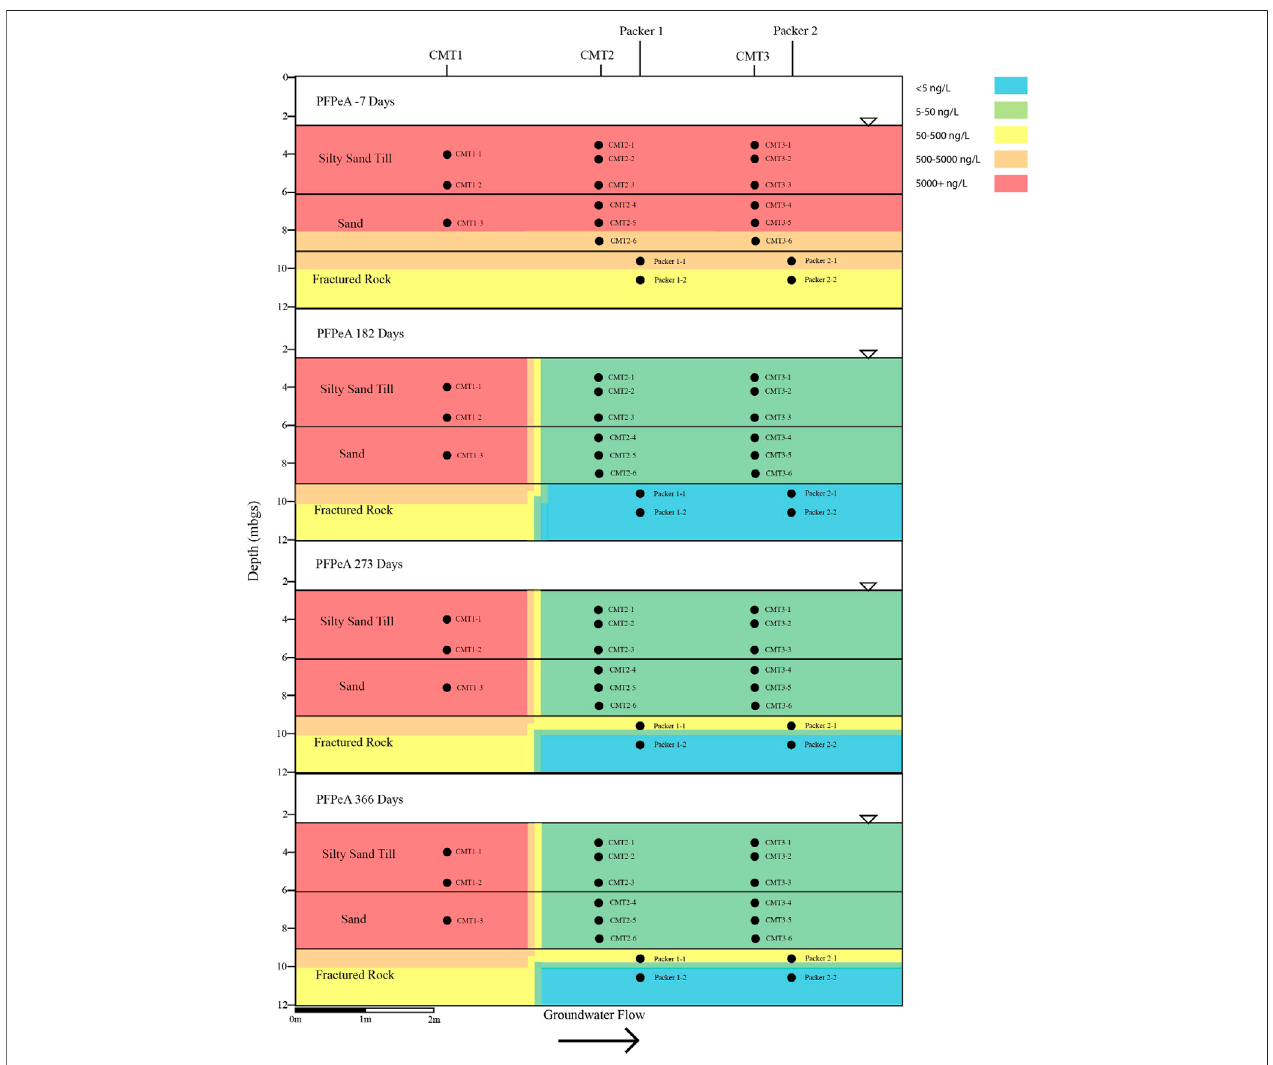
FIGURE 7 | Cross sectional view of PFPeA within groundwater determined pre and post-injection of the CAC within the three aquifers.